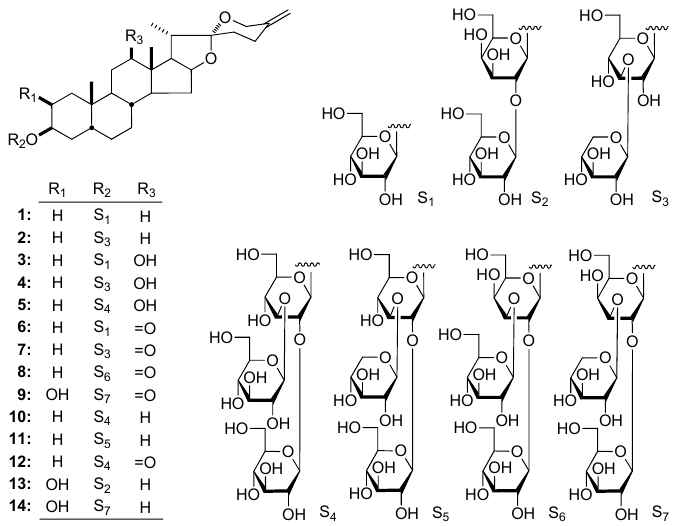
Figure 1. The compounds 1 – 14 obtained from the stems of Y. schidigera .